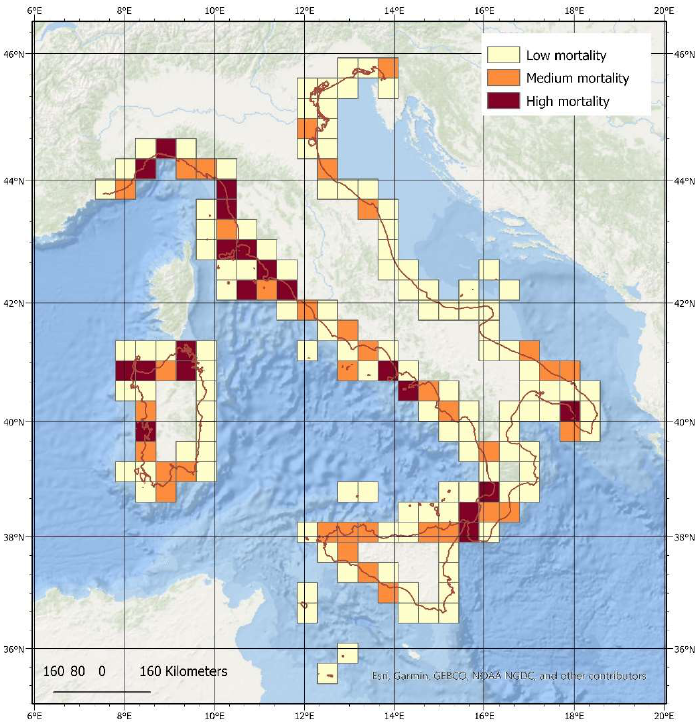
Figure 3. The spatial distribution of fin whale mortality events recorded between 1624 and 2021. Areas with a higher number of mortality events (in dark red) are observed primarily along the coast of the Liguria, Tuscany and northern Sardinia regions and to a lesser extent, along the coast of Campania and in the area of the Strait of Messina. The Italian coastline is highlighted in red.